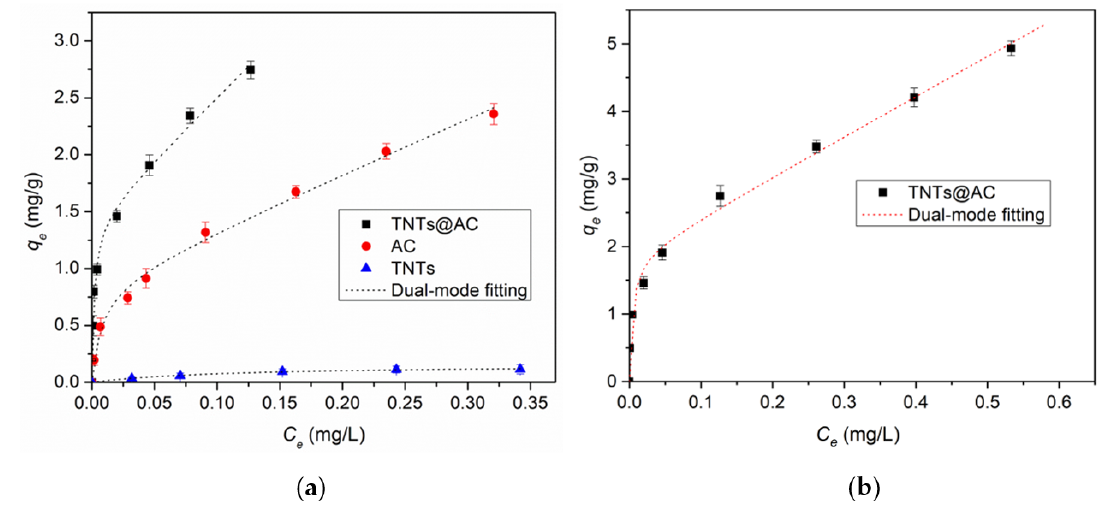
Figure 3. Adsorption isotherms of E2 by various materials ( a ); Adsorption isotherms of E2 at broad initial concentrations by TNTs@AC. (Initial E2 concentration = 0.1–1.5 mg / L ( a ) and 0.25–3.0 mg / L ( b ), material dosage = 0.5 g / L, temperature = 25 ± 0.2 ◦ C, volume of solution = 40 mL, solution pH = 7.0 ± 0.2). Symbols: experimental data; Dash-lines: dual-model fittings.